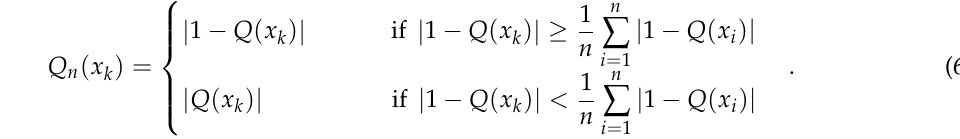
n 1 ∑ | 1 − Q ( x ) | = i n i = 1